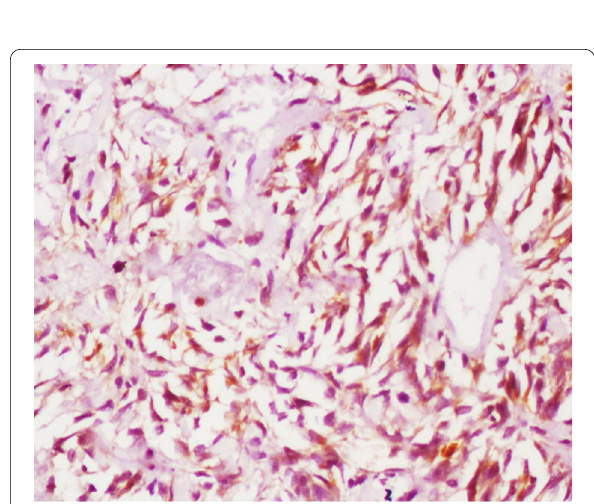
Fig. 4 Photomicrograph showing cytoplasmic S100 protein immunohistochemical positivity in tumour cells (Immunoperoxidase stain,